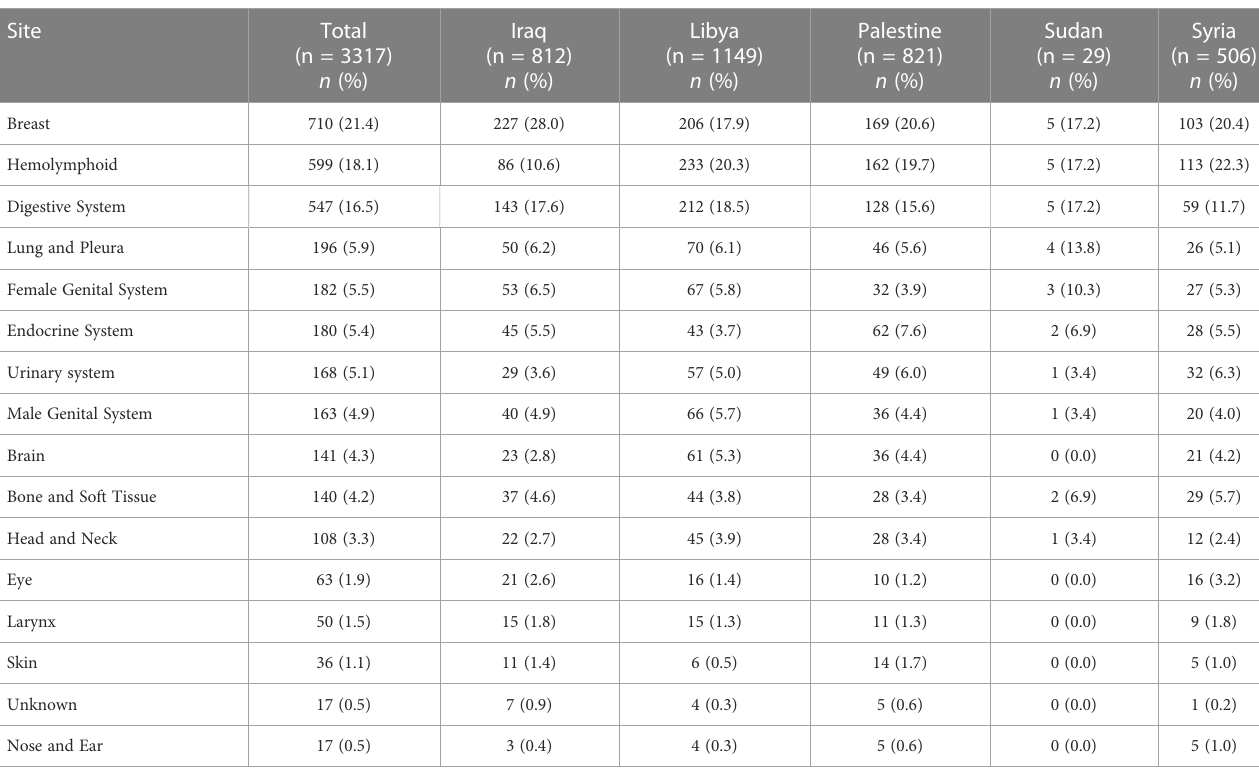
TABLE 1 Site-speci fi c frequencies of cancers in patients from areas of con fl ict who presented to the King Hussein Cancer Center between 2018 and 2021 strati fi ed by nationality. Site